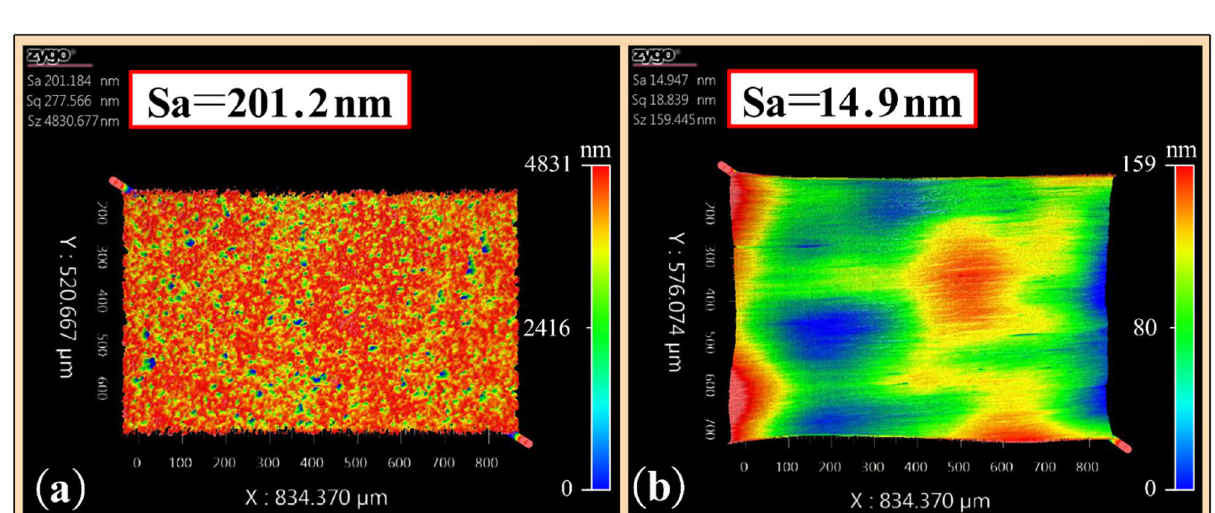
Figure 12. Surface roughness. ( a ) Roughness of initial surface; ( b ) Roughness of polished